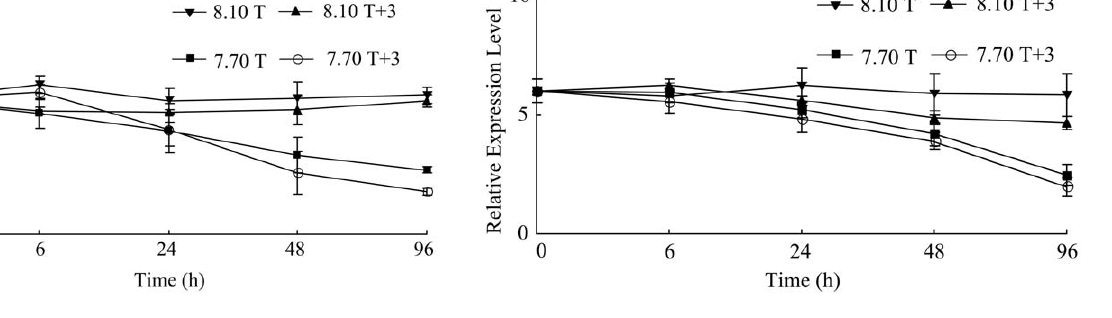
Figure 2. Real-time PCR analysis of expression of calmodulin in response to elevated temperature and declined pH.